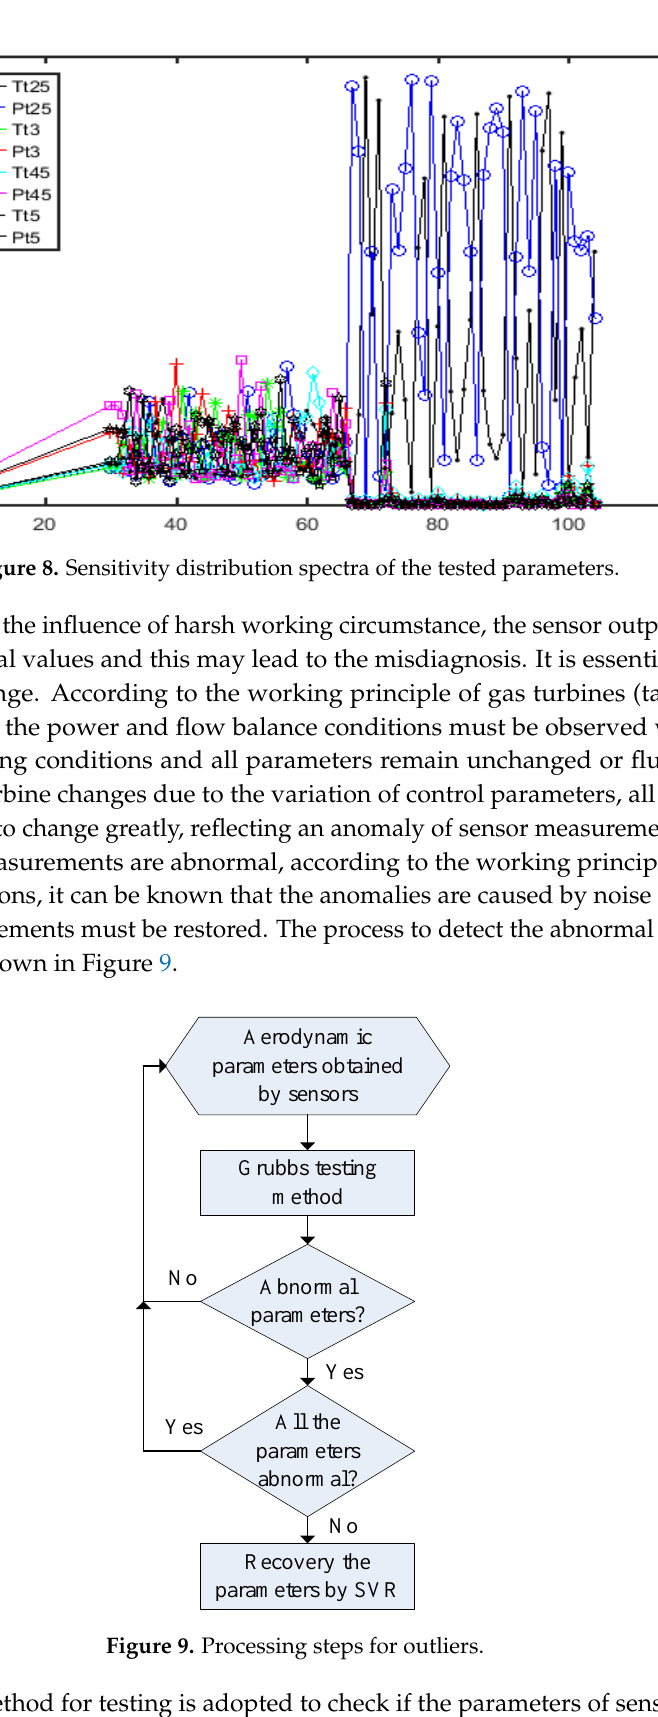
Table 2. The sensitivity of measured parameters. Sensitivity